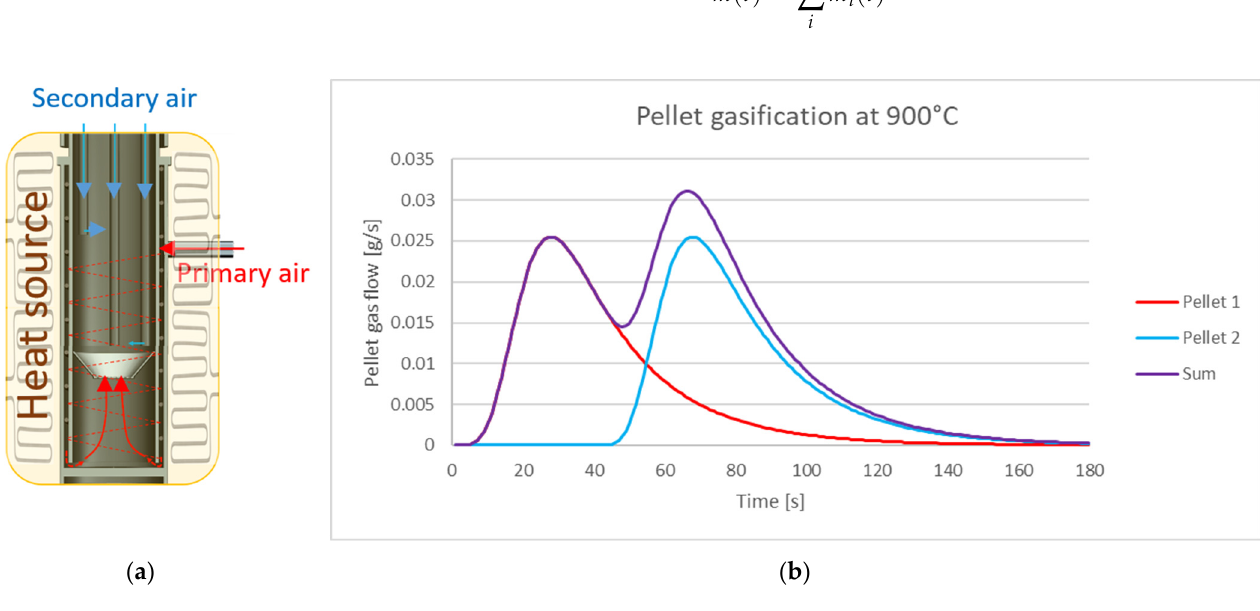
Figure 4. Test rig to measure pellet mass loss ( a ) and the corresponding pellet gas flow ( b